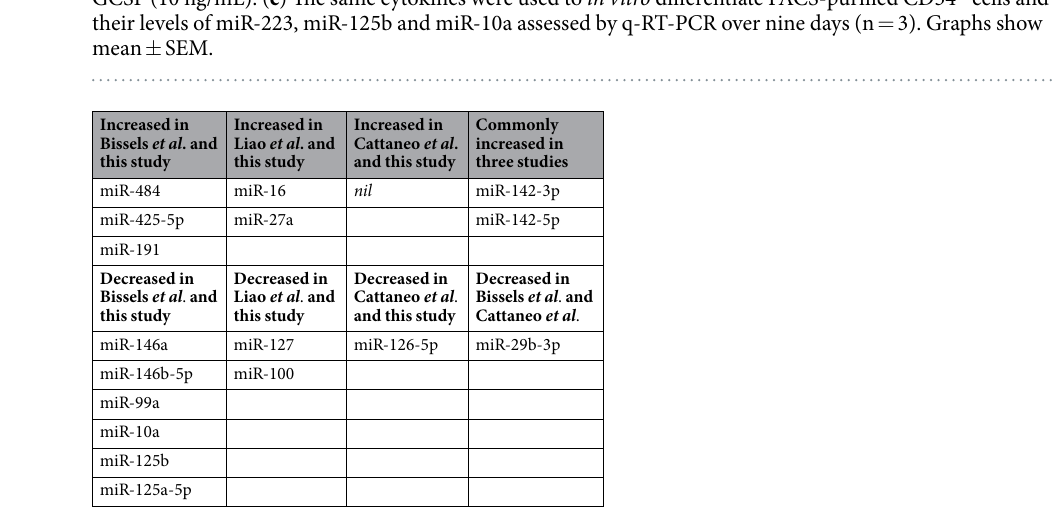
Table 2. Stem/progenitor microRNAs that consistently increase and decrease during differentiation as demonstrated by Bissels et al . 35 , Liao et al . 36 , Cattaneo et al . 20 and this